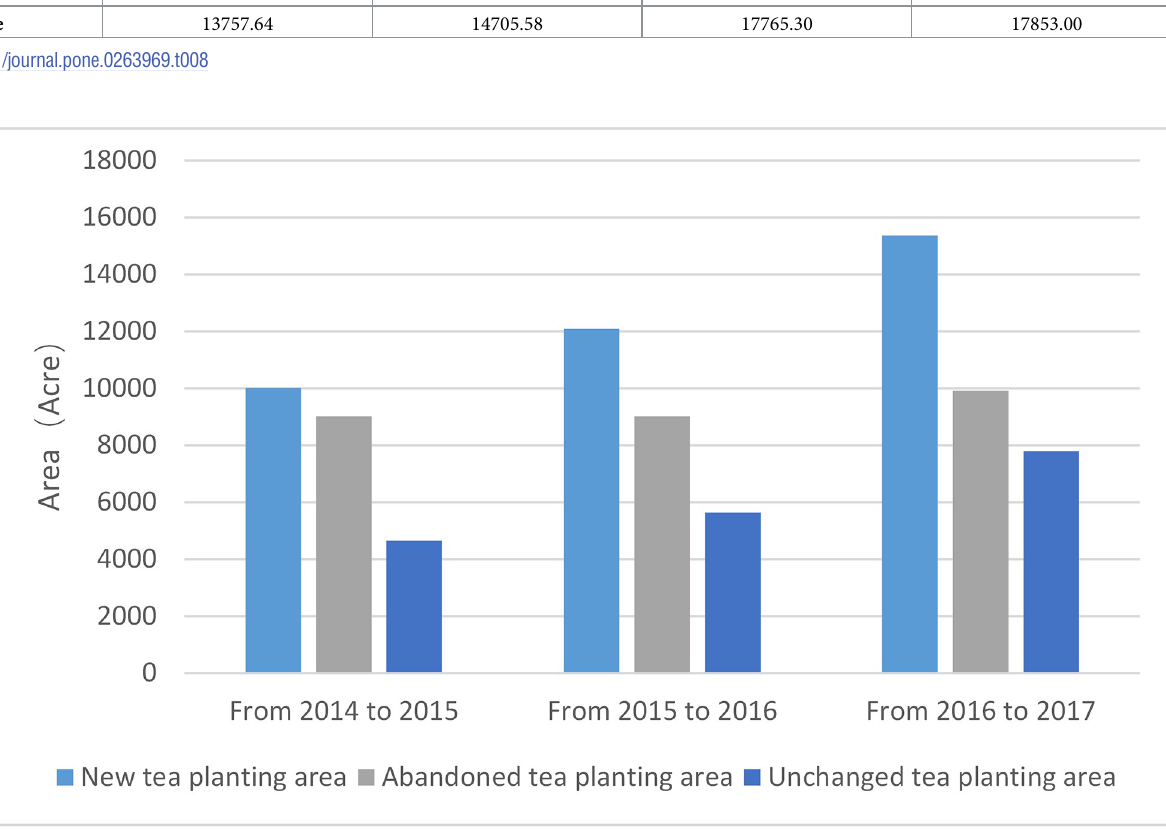
Fig 12. Spatial variation from 2014 to